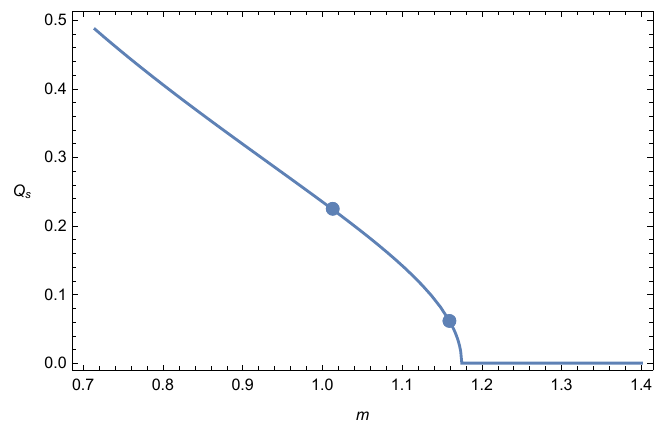
Figure 2 . The relationship between the scalar charges Q s and ADM masses m of the static HBH solutions numerically evaluated by the present model. The profiles of two static HBH solutions indicated by filled circle and square on the curve are shown below in figure